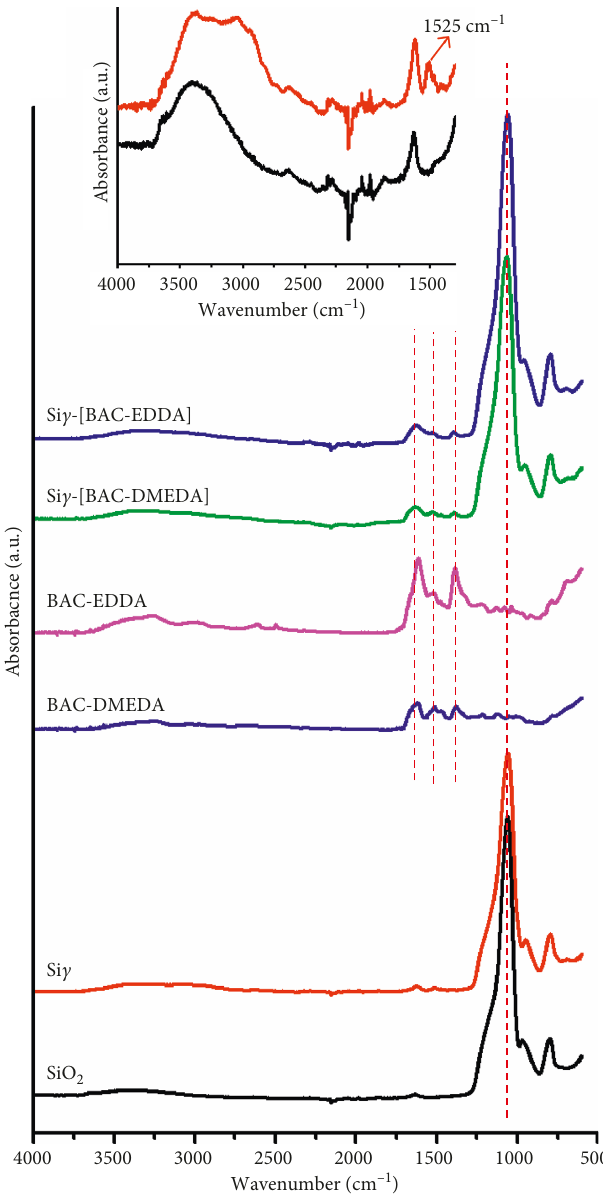
Figure 2: FTIR spectra of silica (SiO c ), 2 ), aminated silica (Si linear polymers ([BAC-DMEDA], [BAC-EDDA]), and polymer- grafted materials (Si c -[BAC-DMEDA], Si c -[BAC-EDDA]). Inset shows the amplified spectra of silica (SiO 2 ) and aminated silica (Si c ) within the wavenumber region of 4000 and 1700 cm − 1